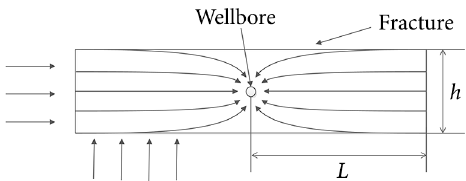
Figure 8. Schematic diagram of fluid flow from formation to fractures and from fractures to horizontal